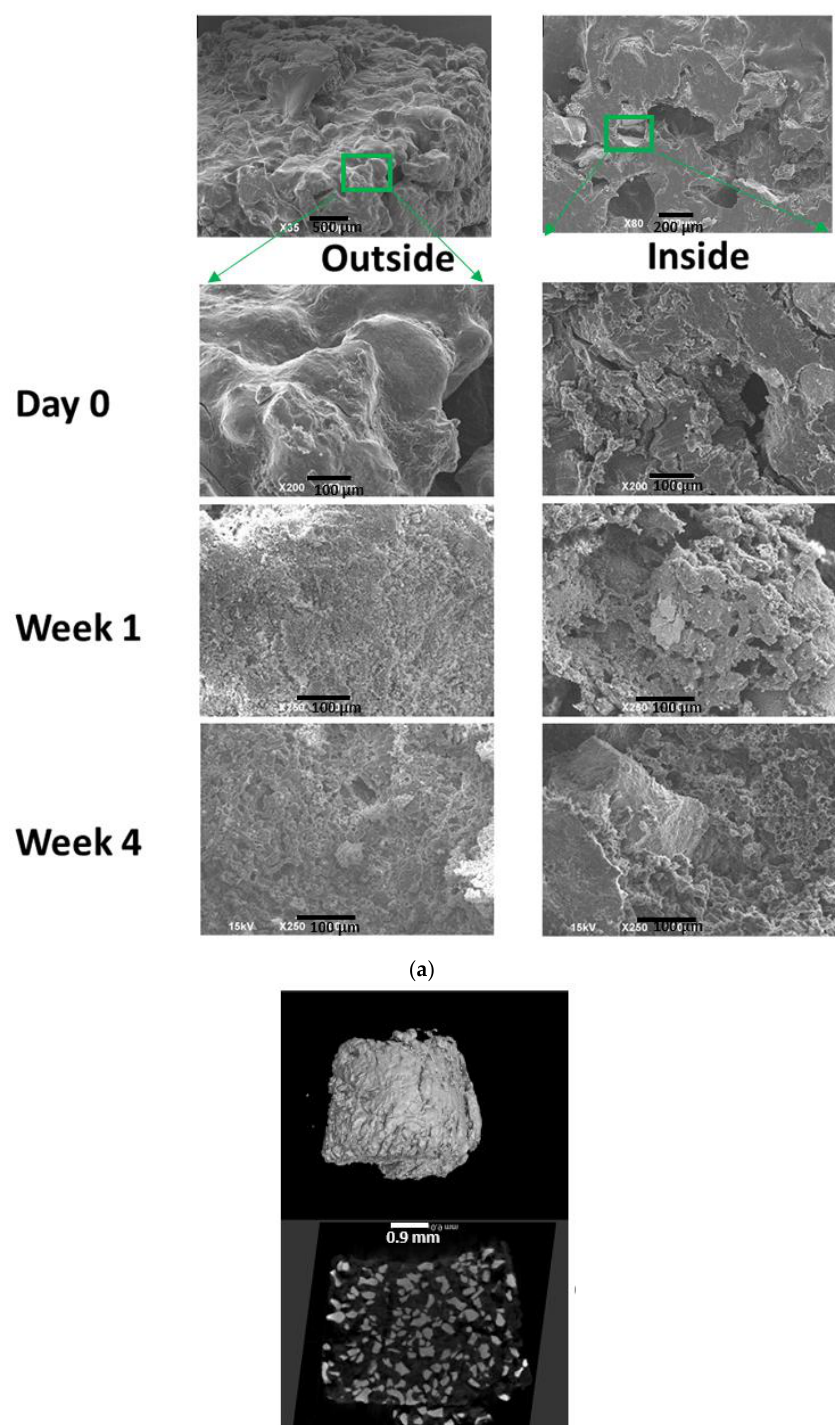
Figure 1. ( a ) SEM image of ABVF after manufacturing. The outer surface is rough (top left corner) and the inner surface has pores (top right corner). SEM images of ABVF degradation in phosphate bu ff ered saline at di ff erent time points, showing increasing signs of degradation on both the outer and inner surfaces of the ABVF. ( b ) The micro-computed tomography image of ABVF shows a homogenous distribution of the PRO OSTEON particles in the polymer